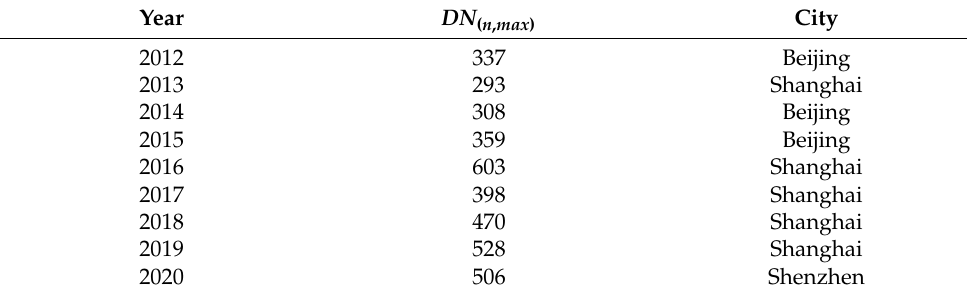
Table 1. Maximum DN values and corresponding cities by year. Year DN ( n , max